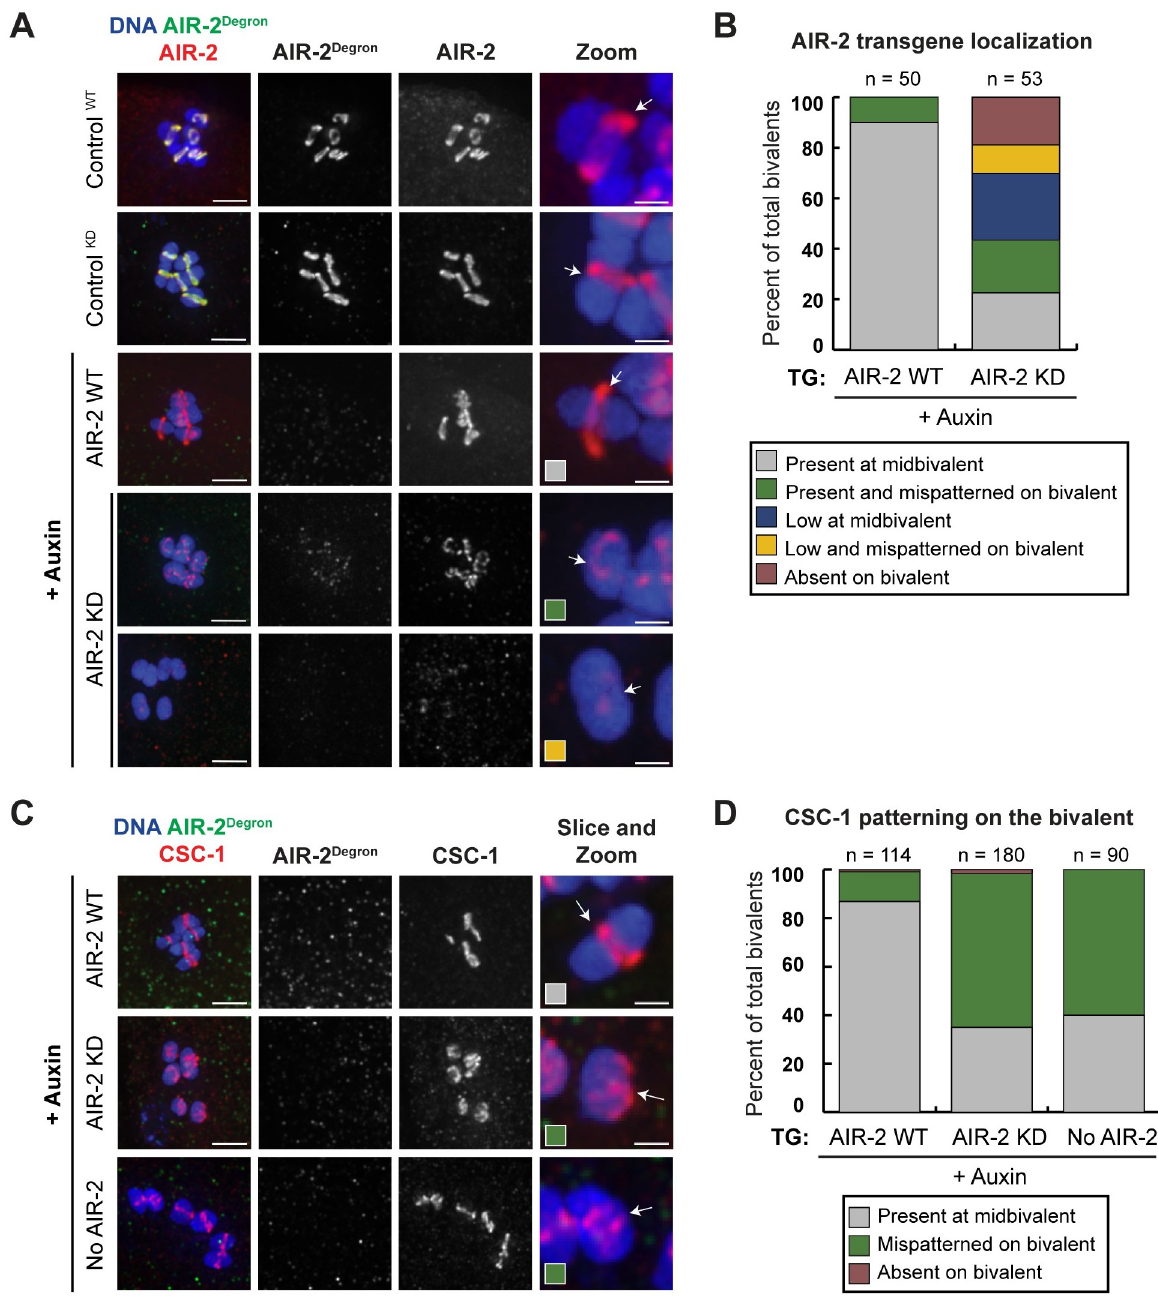
Fig 2. AIR-2/Aurora B kinase activity is required for proper Chromosomal Passenger Complex (CPC) recruitment and patterning on the bivalent. (A) In the absence of auxin (top two rows), transgenic wild-type and kinase-dead AIR-2 (visualized by the AIR-2 antibody, “AIR-2”, red) localize to the midbivalent when endogenous AIR-2 (visualized by the degron antibody, “AIR-2 Degron ”, green) is present. In the presence of auxin, endogenous AIR-2 is depleted; under these conditions the wild-type transgenic AIR-2 can localize to the midbivalent but the kinase-dead version is either mispatterned or absent. Arrows mark the midbivalent region and colored boxes in the zoomed images represent the categories quantified in part B. (B) Quantification of transgenic AIR-2 localization (either WT or KD) following depletion of endogenous AIR-2; descriptions of each category in Materials and methods. (C) All images are following auxin incubation, to deplete endogenous AIR-2 (imaged with the degron antibody, green). In the presence of wild-type transgenic AIR-2, CSC-1 (red) localizes to the midbivalent, while in the presence of transgenic kinase-dead AIR-2 or with no transgene, CSC-1 is mispatterned. Arrows mark the midbivalent region. (D) Quantification of CSC-1 localization following depletion of endogenous AIR-2, in strains expressing either transgenic WT or KD AIR-2, or with no transgenic AIR-2. Bars = (A) 2.5 μ m (A, zoom) 0.85 μ m; (C) 2.5 μ m (C, zoom) 0.85 μ